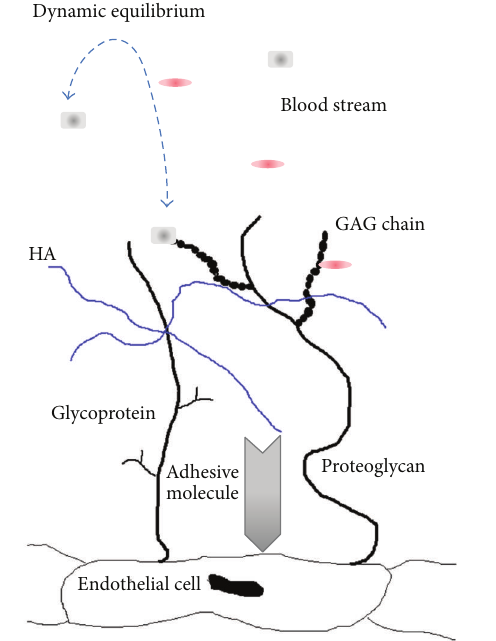
Figure 1: Structure of glycocalyx: the backbone molecules, glycoproteins and proteoglycans; GAG chains linked to core proteins; soluble molecules derived from plasma or endothelium bound to proteoglycans; intertwined HA molecules; sheltered adhesive